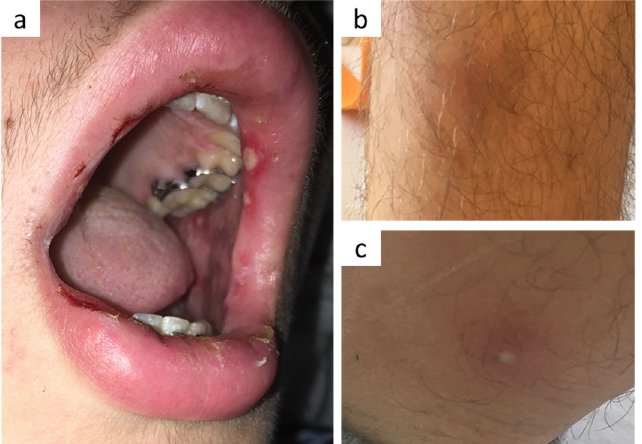
Figure 1. ( a ) Oral aphthous ulcers on lips and inner cheeks, ( b ) erythema nodosum-like lesions and ( c ) a single pustular lesion on his lower legs